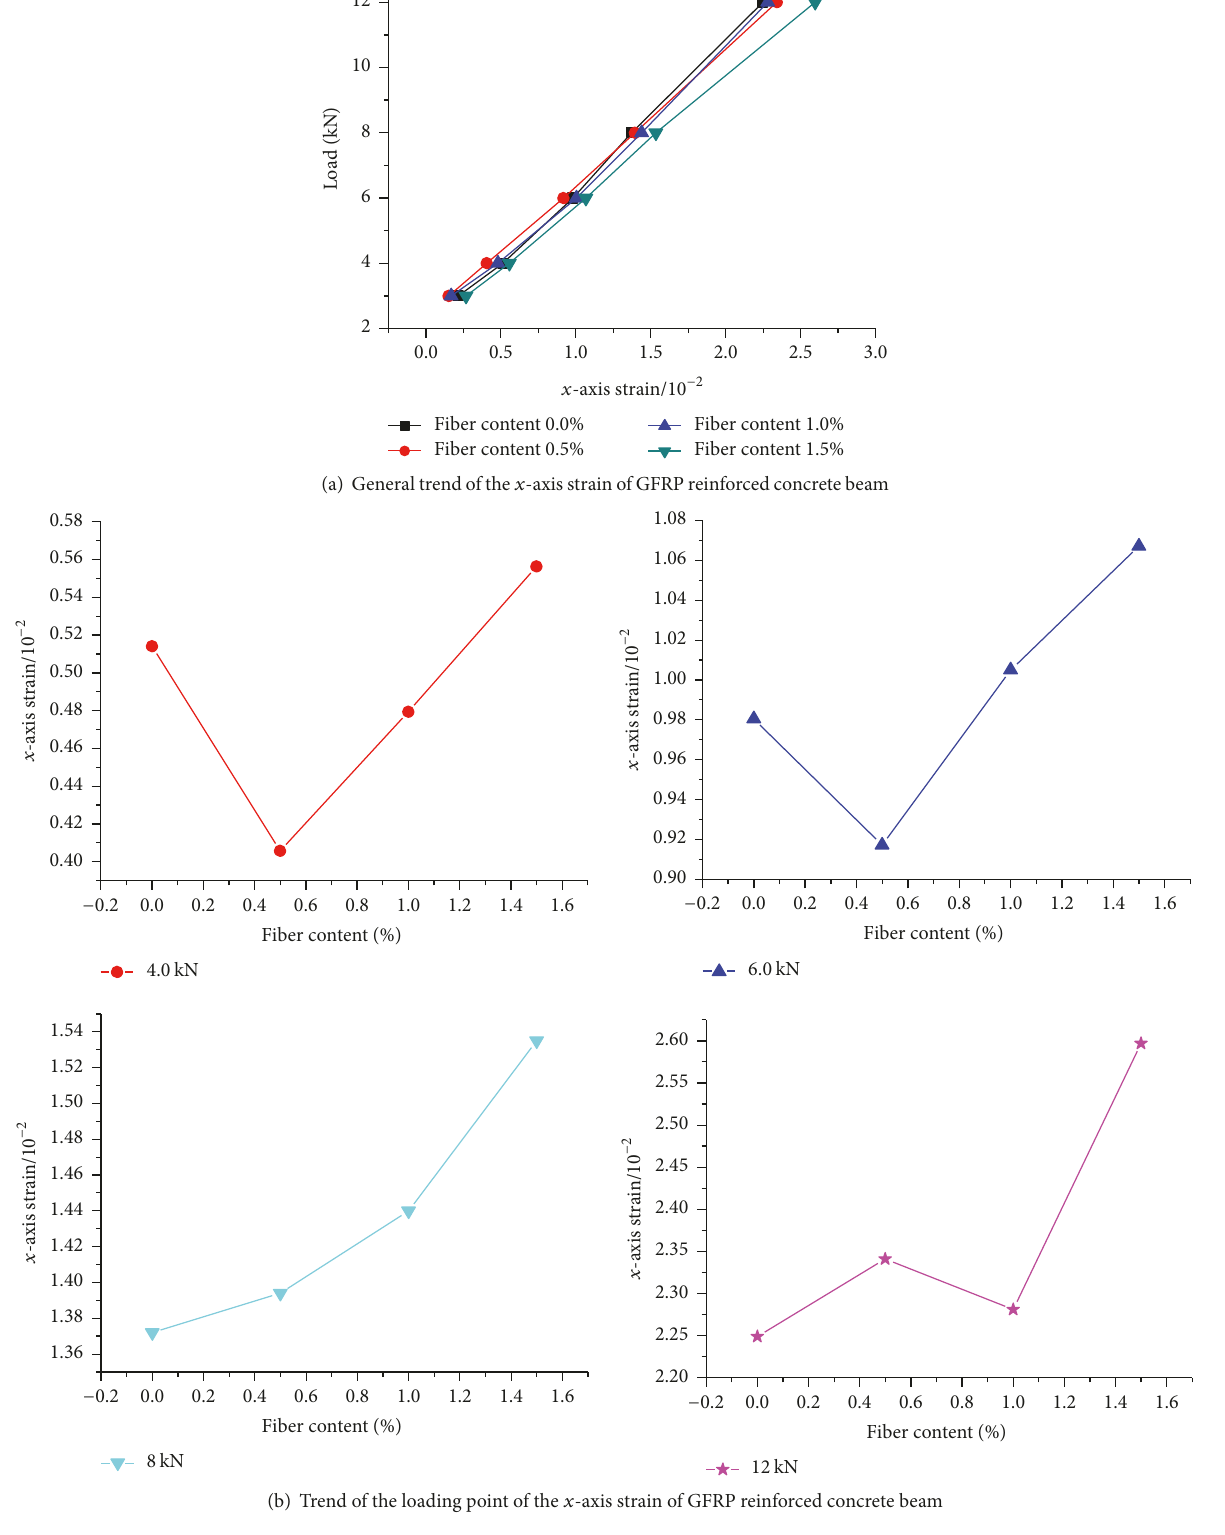
Figure 10: Trend of the 𝑥 -axis strain of GFRP reinforced concrete